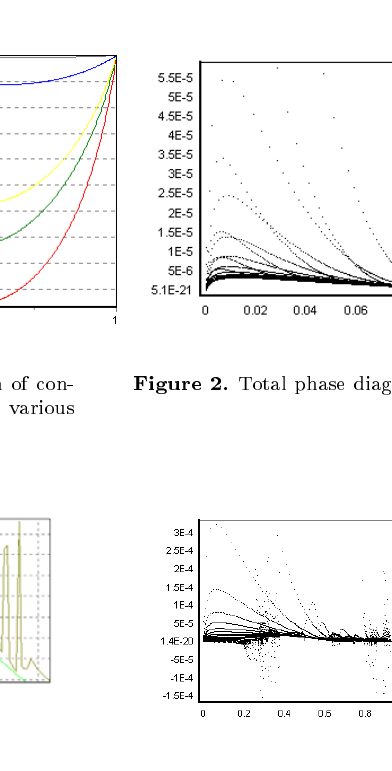
alongx(cid:13)axisatvarioustimemoments